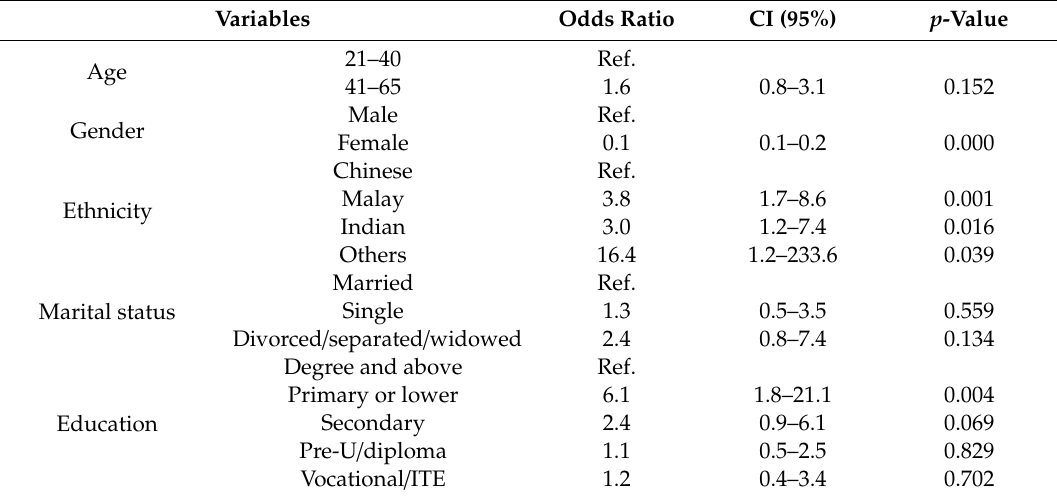
Table 3. Factors associated with ever smoking among psychiatric